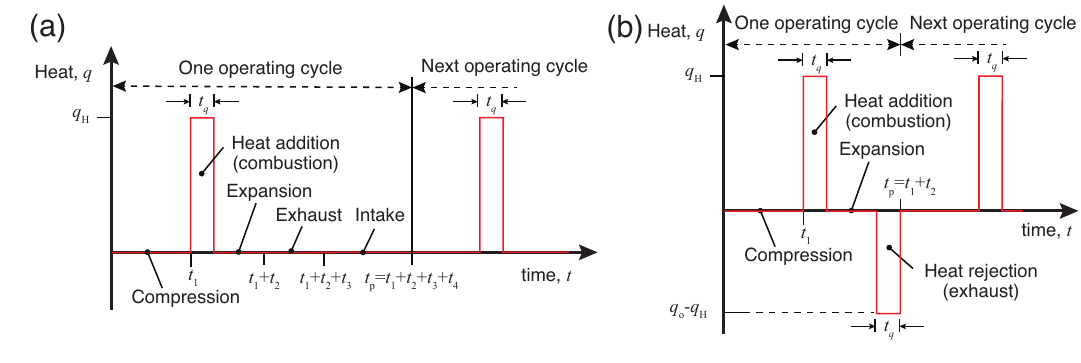
Figure 3. Heat-rate function q for modeling the ( a ) open and ( b ) closed cycle